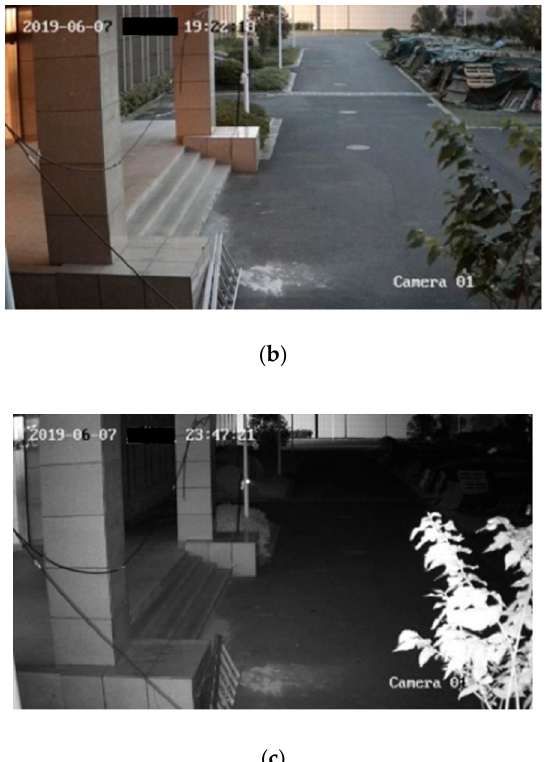
Figure 4. Images in the same visibility (10,000 m) at different time. ( a ) daytime image; ( b ) evening image; ( c ) late-night image.